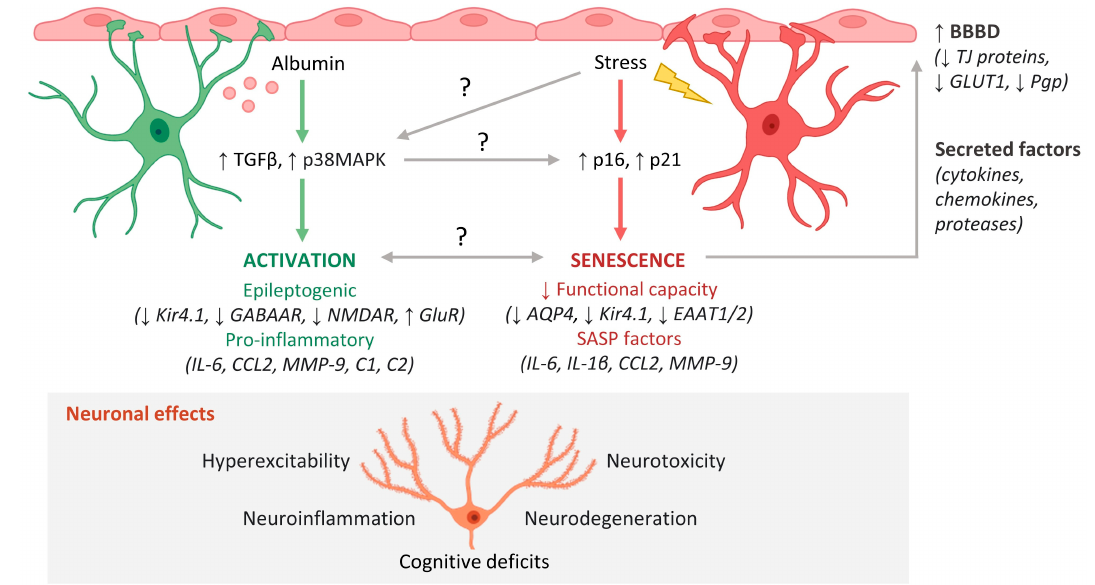
Figure 1. Mechanisms of astrocyte-mediated neuropathology in the aging brain. Blood–brain barrier dysfunction (BBBD) and cellular senescence progressively increase during aging and are associated with an increased risk of neurodegenerative disease. Two processes that result in dysfunctional astrocyte phenotypes and subsequent neuropathology are BBBD-associated astrocyte activation and astrocyte senescence. BBBD causes albumin to leak into the brain, where it activates TGF β and p38MAPK signaling in astrocytes, which elicits an epileptogenic and pro-inflammatory astrocyte phenotype. The epileptogenic phenotype is characterized by downregulation of K+ transporters (Kir4.1), inhibitory GABA A receptors (GABAAR), and NMDA receptors (NMDAR) and upregulation of excitatory glutamate receptors (GluR). Second, certain types of cellular stress cause expression of tumor suppressors p16 and p21, which elicit a senescent phenotype characterized by decreased functional capacity and SASP expression. This decreased capacity involves downregulation of aquaporin 4 (AQP4), K+ transporters (Kir4.1), and glutamate transporters (EAAT1/2). Factors such as cytokines, chemokines, and proteases secreted by activated and senescent astrocytes may act on the endothelium to further exacerbate BBBD via downregulation of tight junction (TJ) proteins, glucose transporters (GLUT1), and waste efflux transporters (Pgp). Dysfunctional astrocytes contribute to neuronal hyperexcitability, neuroinflammation, neurotoxicity, and neurodegeneration, which manifest as cognitive deficits in the aging brain. Questions remain regarding the mechanistic links and relationships between BBBD-associated astrocyte activation and senescence. This figure was created with cell images from